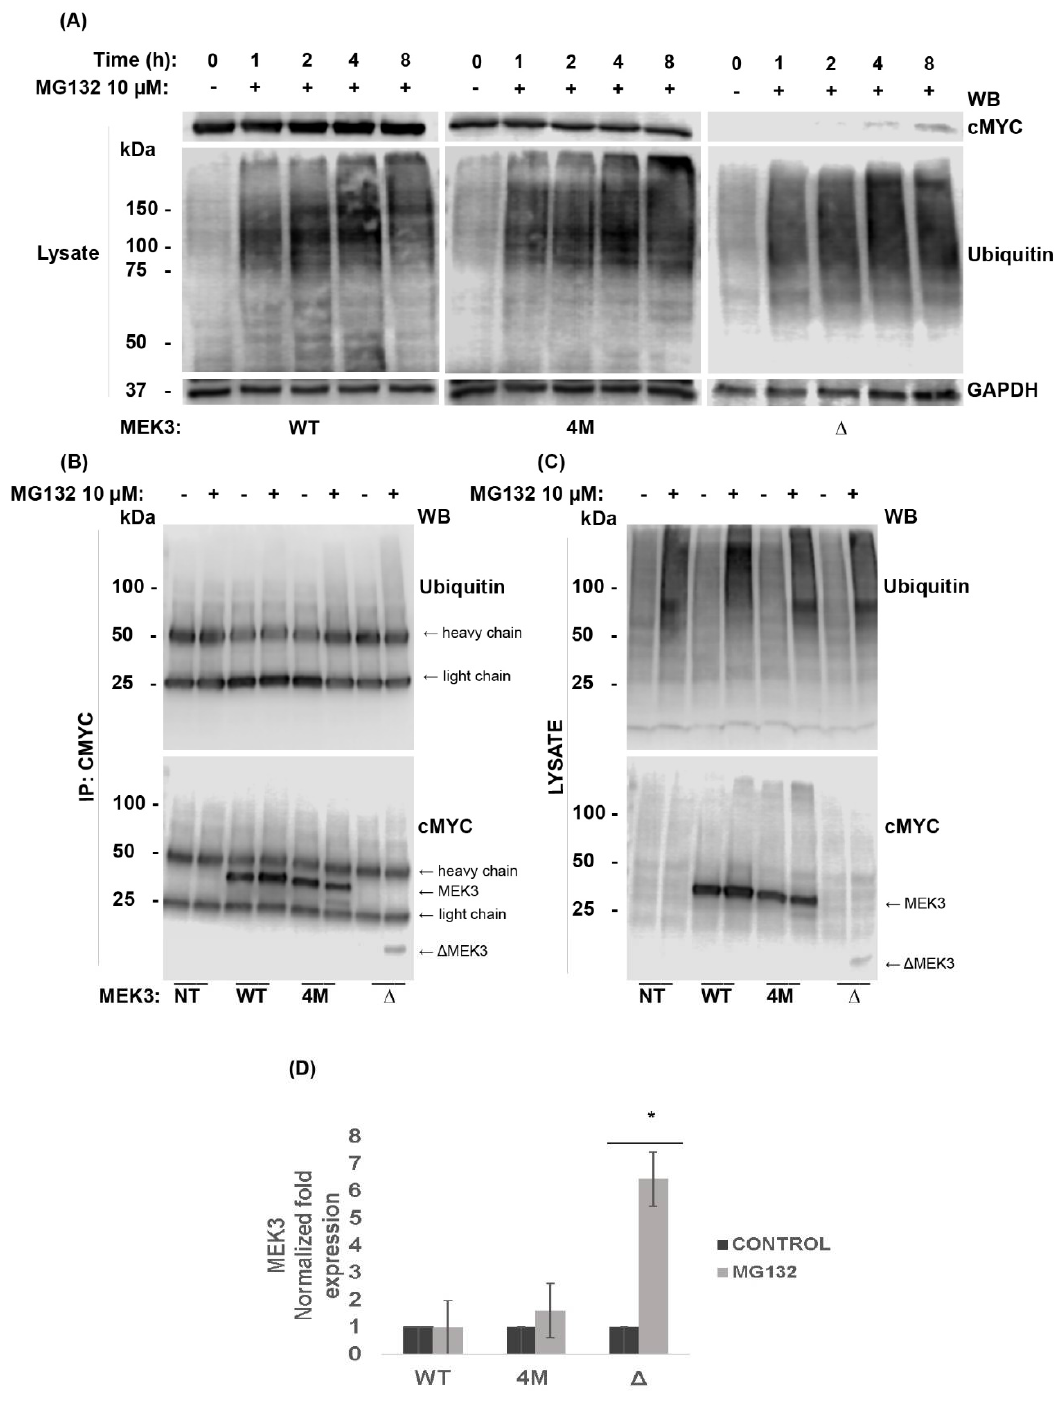
Figure 6. Degradation of truncated MEK3 mutant by the proteasome is ubiquitin-independent . HEK293 cells were not transfected (NT) or transiently transfected concurrently with WT-cMYC or MEK3-cMYC constructs (4M-MEK3 and Δ- MEK3). After 24 hours of transfection, cells were left untreated (−) or treated with MG132 (+) as per the indicated time points. ( A ) Cell lysates were separated by SDS-PAGE and immunoblotted as indicated. ( B ) Transfected cells were treated with DMSO (−) or MG132 (+) for 8 h and immunoprecipitated (IP) for cMYC, and ( C ) probed using cell lysate. Samples were separated by SDS-PAGE and immunoblotted (WB) as indicated. ( D ) Quantified protein expression of WT-MEK3 or MEK3 constructs is shown relative to time 0. Band intensities were normalized to GAPDH using densitometric analysis and presented as a ratio of cMYC to GAPDH. Data are presented as mean ± SEM ( n = 3). T-test (unpaired) was used to determine statistical significance. *, p < 0.05.